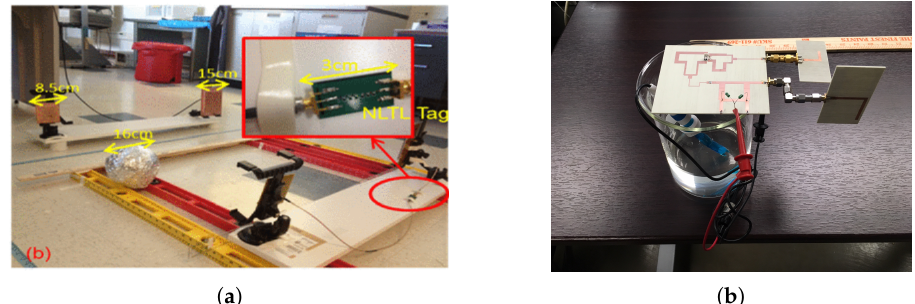
Figure 3. ( a ) Harmonic phase based localization in the presence of a scatterer [35] [Reproduced with permission from Y. Ma, Accurate indoor ranging by broadband harmonic generation in passive NLTL backscatter tags; published by IEEE, 2014]. ( b ) Harmonic phase-based sensing with better immunity to background clutter [36]. [Reproduced with permission from S. Mondal, A wireless passive pH sensor with clutter rejection scheme; published by IEEE,